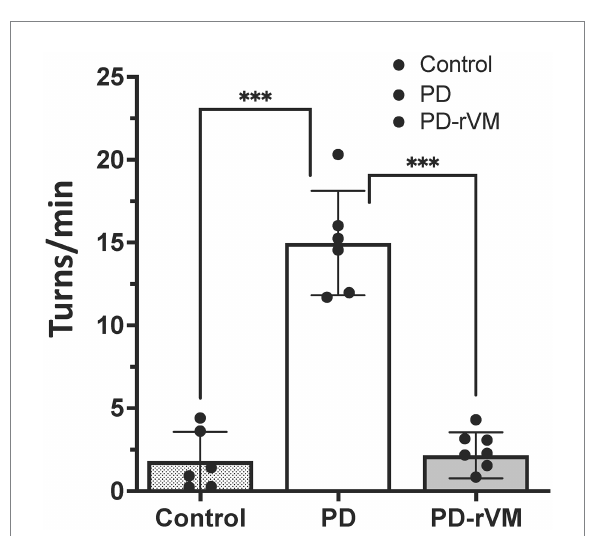
FIGURE 4 METH-induced rotation in 6-OHDA lesioned PD rats. Average turning rates of the control, PD, and PD-rVM groups. Student’s t -test, n = 6 per group; *** p < 0.005 compared to control or PD